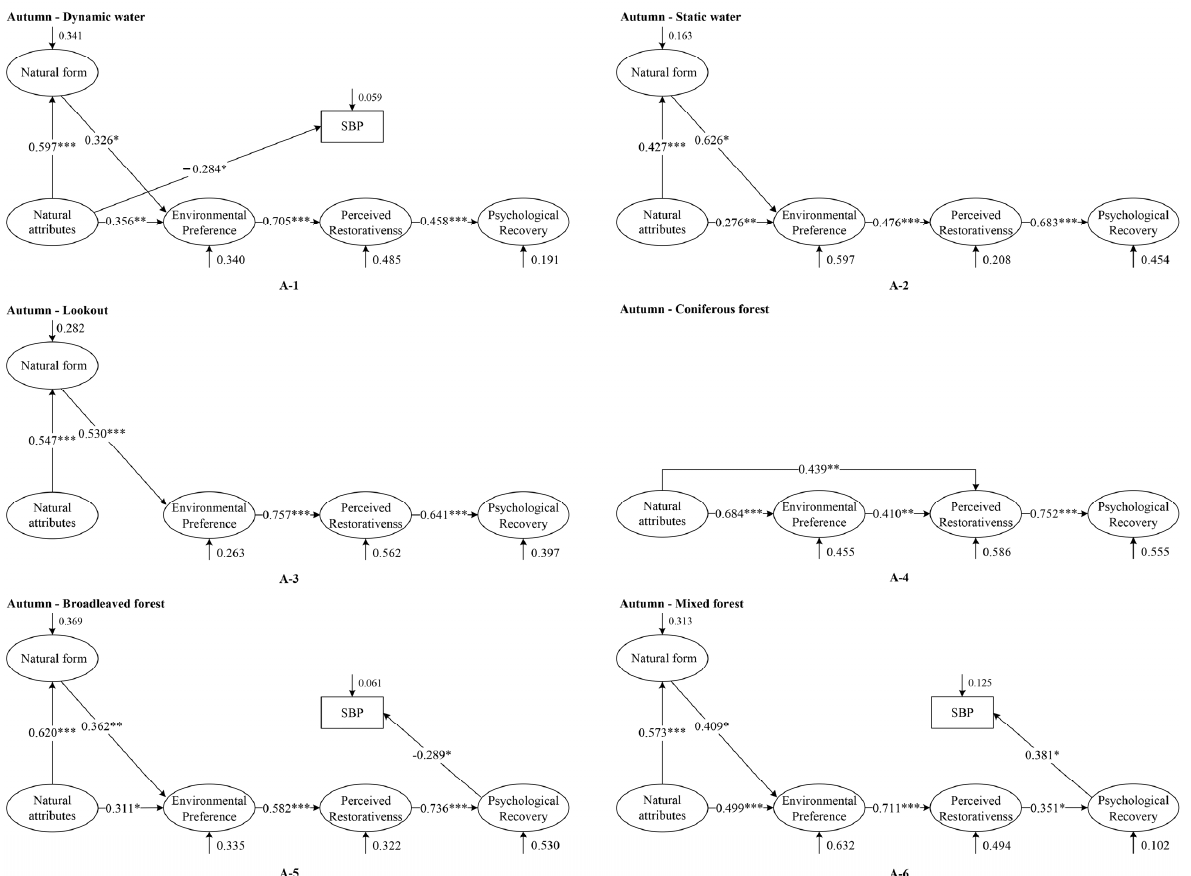
Figure A1. The relationship between landscape perception and physical and mental recovery in different spring spaces. ( A-1 ) Spring dynamic water landscape. ( A-2 ) Spring static water landscape. ( A-3 ) Spring lookout landscape. ( A-4 ) Spring coniferous forest landscape. ( A-5 ) Spring broadleaved forest landscape. ( A-6 ) Spring mixed forest landscape. * p < 0.05; ** p < 0.01; *** p < 0.001. SBP: systolic blood pressure; DBP: diastolic blood pressure; HR: heart rate. This figure was created by Rui Chen.